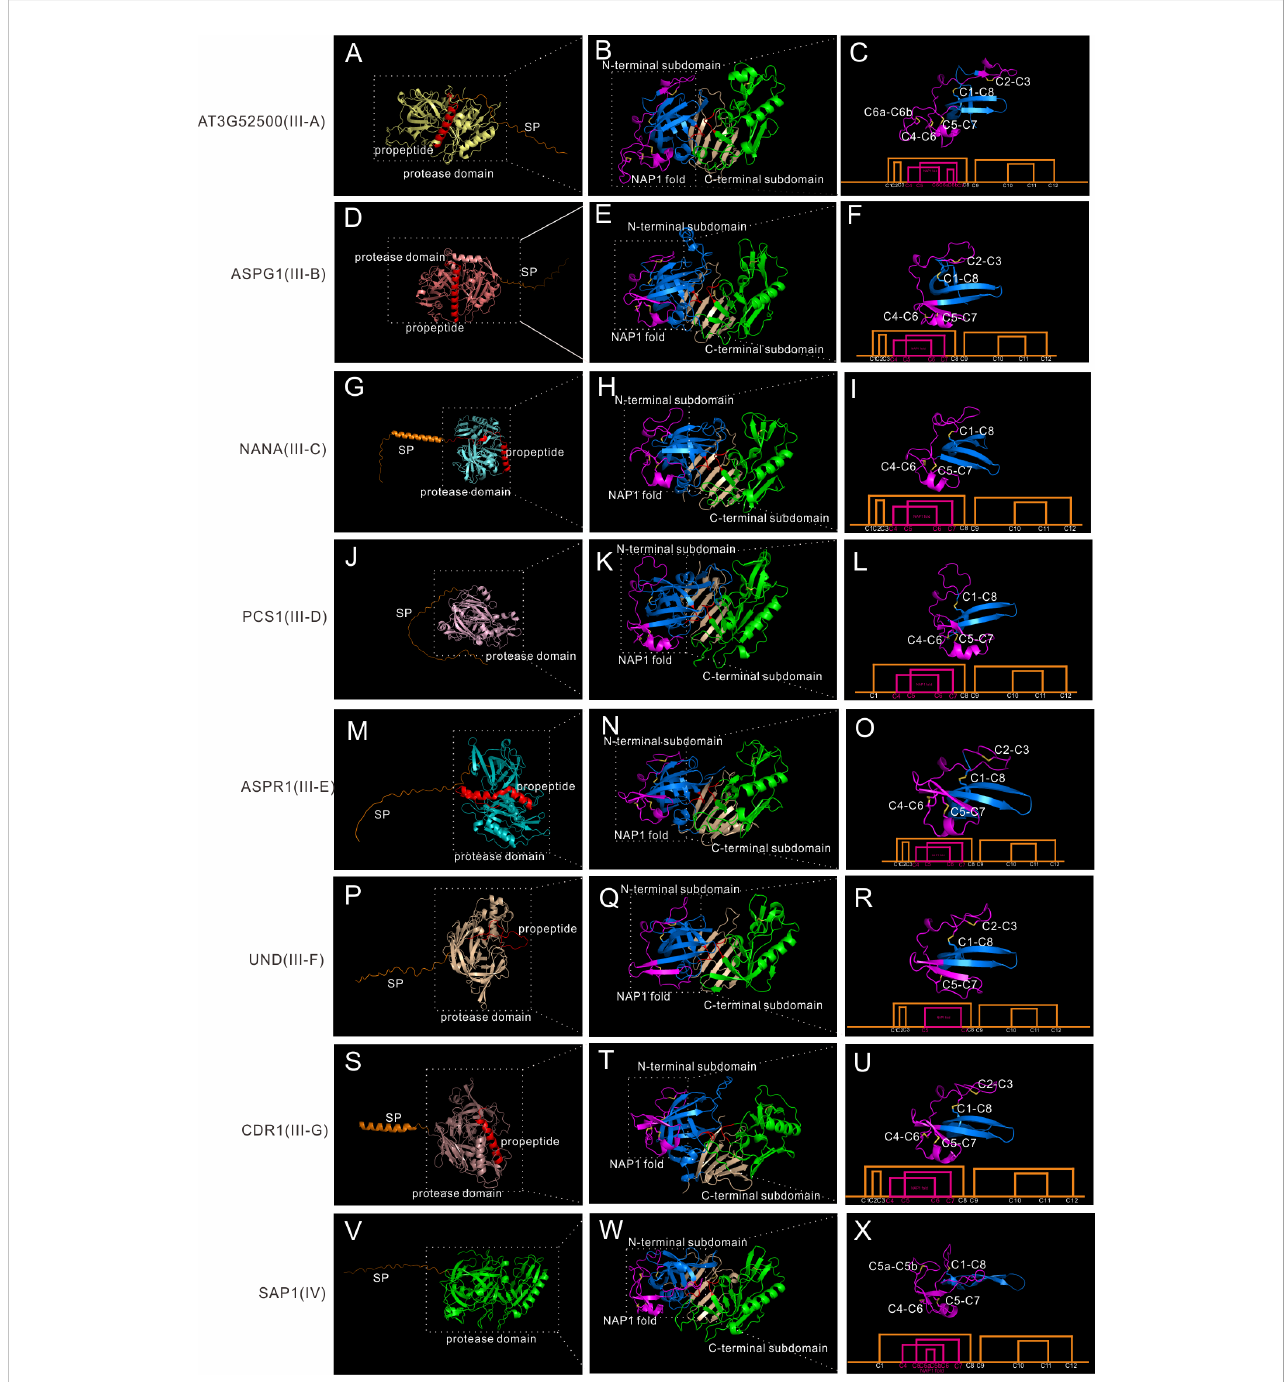
FIGURE 5 AlphaFold predicted structure models of group III and group IV. (A-C) Structure and disul fi de bond topology of III-B(AT3G52500); (D – F) Structure and disul fi de bond topology of III-C (ASPG1); (G – I) Structure and disul fi de bond topology of III-D (NANA); (J – L) Structure and disul fi de bond topology of III-E (PCS1); (M – O) Structure and disul fi de bond topology of III-F (ASPR1); (P – R) Structure and disul fi de bond topology of III-G (UND); (S – U) Structure and disul fi de bond topology of III-H (CDR1); (V – X) . Structure and disul fi de bond topology of IV